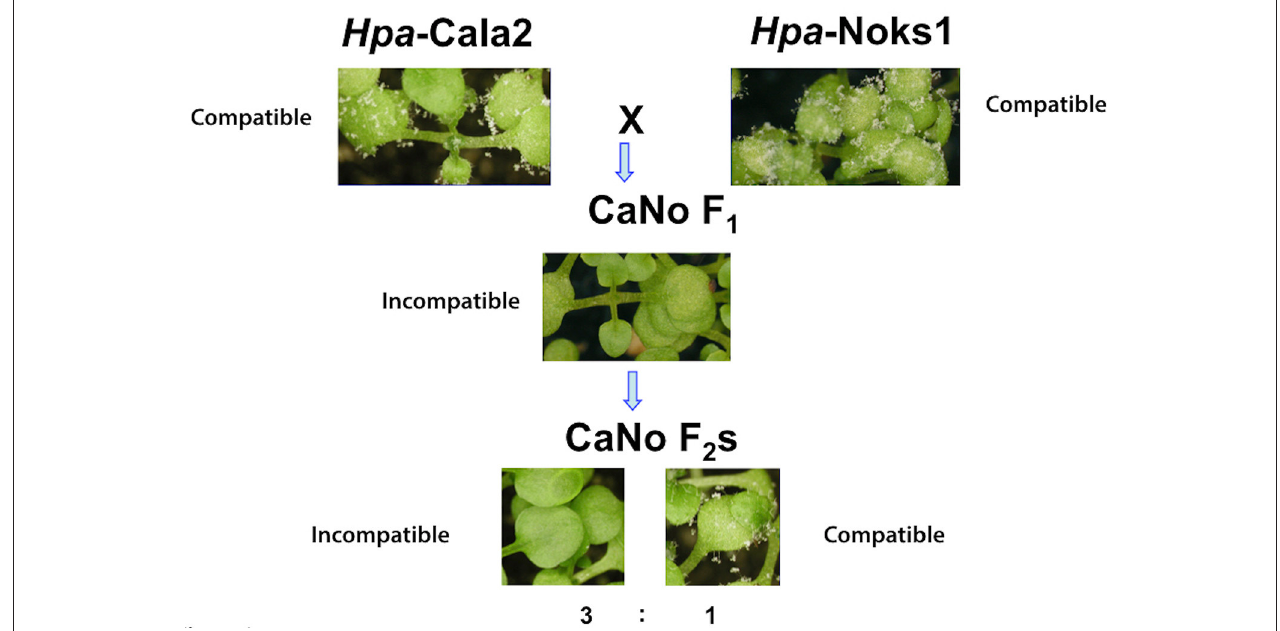
FIGURE 1 | Avirulent determinant HAC1 was identified from the segregating F 2 population. The parental isolates Hpa -Noks1 and Hpa -Cala2 displayed a compatible interaction while CaNo F 1 showed an incompatible interaction with RMX-A02 and CaNo F 2 isolates segregating in a 3,1 (avirulent, virulent)